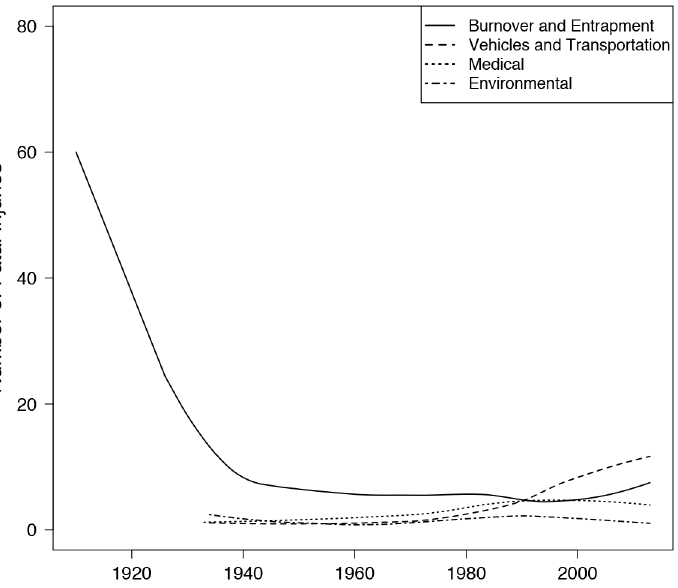
Fig 3. Number of fatal injuries in wildland fire from 1922 – 2013. (A) Fatal injuries are separated into 4 categories: those directly resulting from fire, those resulting from the use of vehicles and transportation, medical related, and environmental related. Trend in number of fatal injuries over time for each category is represented by locally weighted scatterplot smoothing (LOWESS) of the number of fatal injuries in each category over time.